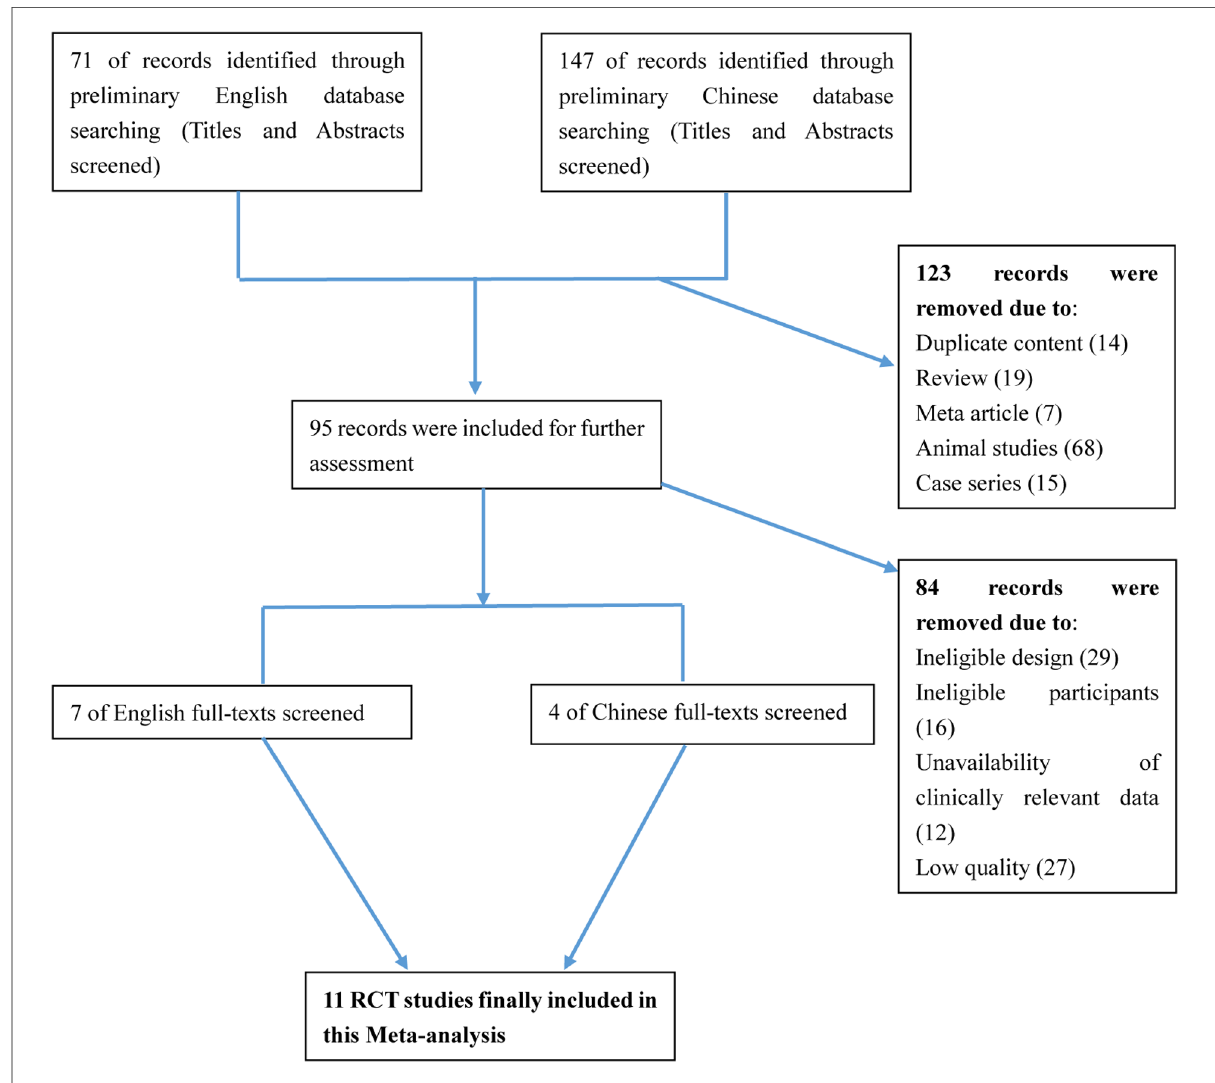
FIGURE 1 Flow diagram of selection of studies for inclusion in the